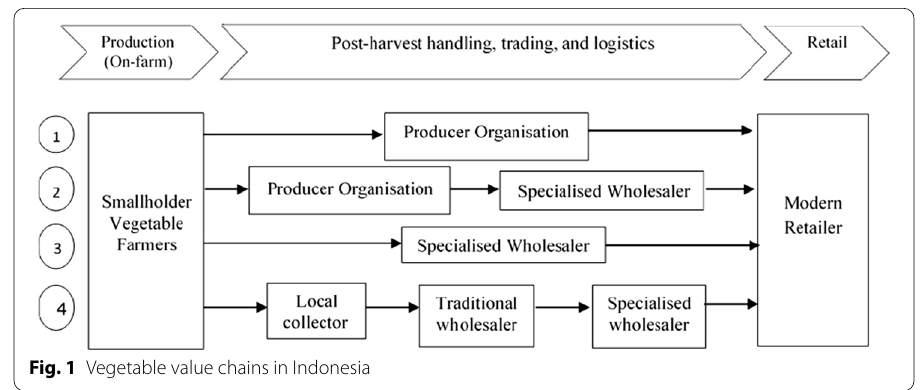
Fig. 1 Vegetable value chains in